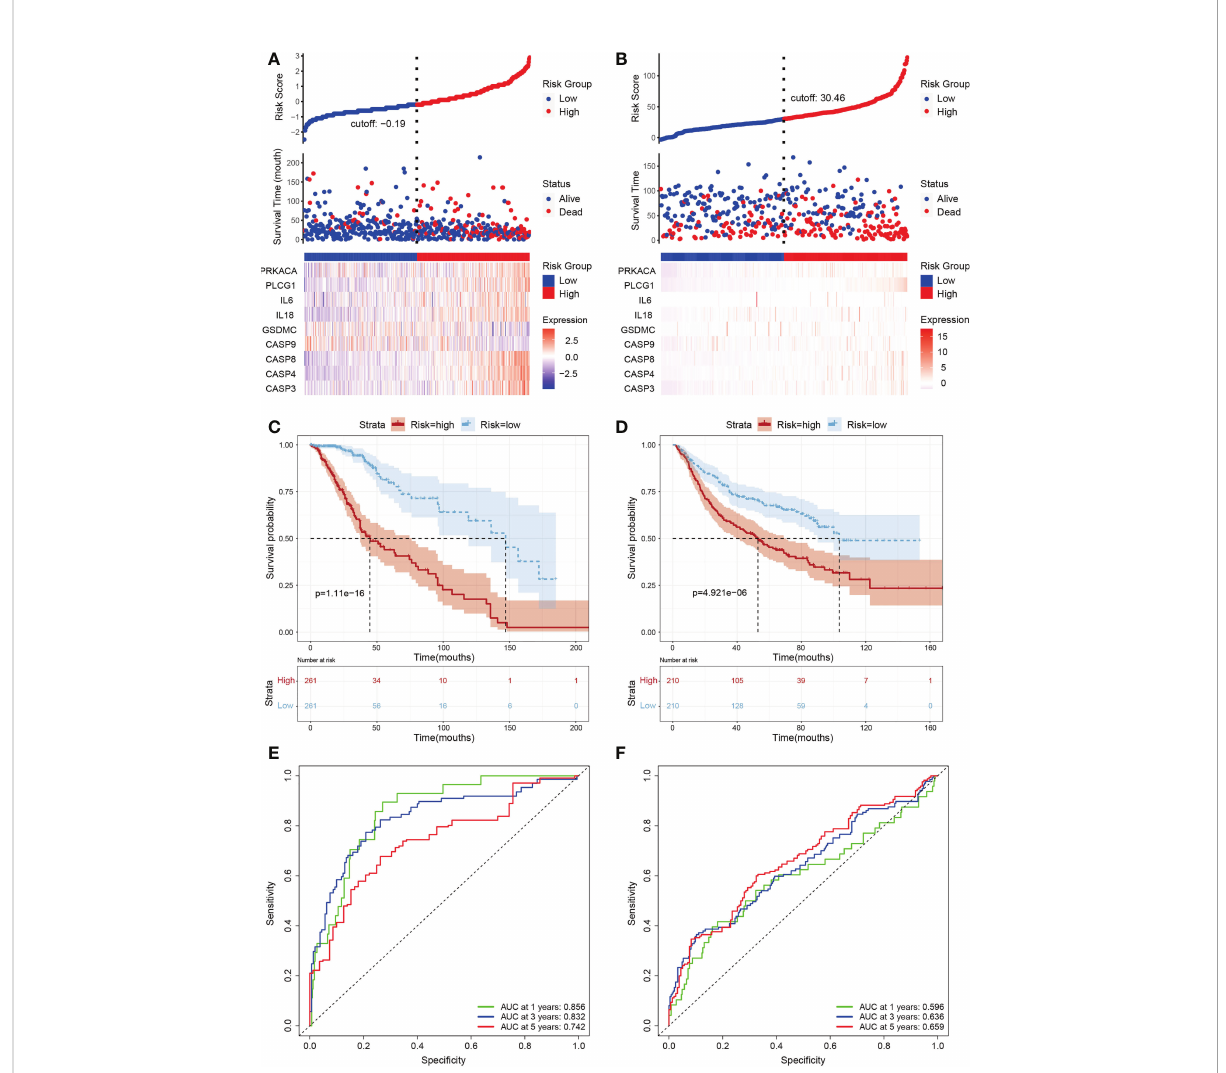
FIGURE 3 Subgroups of LGGs based on the construction of risk signature. (A, B) Distribution of risk score, differences in survival between the high- and low-risk groups and heatmap of the expression patterns of 9 pyroptosis-related genes in the training set (A) and testing set (B) . Red dots indicate dead, whereas blue dots indicate live. (C, D) Kaplan-Meier curve for the OS of LGG patients in the high- (n=194) and low-risk (n=194) groups in the TCGA training cohort (C) and the CGGA (n=420) testing cohort (D) . The red curve represents the high-risk group, and the blue curve represents the low-risk group. (E, F) Time-dependent ROC curve based on the prognostic model regarding OS and survival status in the TCGA training cohort (E) and the CGGA testing cohort (F) . Green, blue and red curves represent 1-year, 3-year and 5-year,